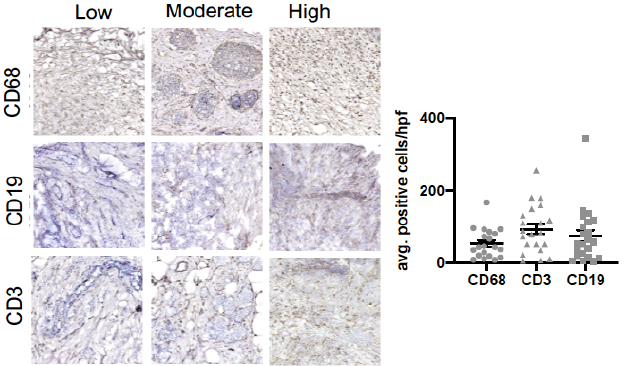
Figure 1. B cell, T cell and macrophage infiltration in breast tumor samples . Immunohistochemical analysis of breast tumor samples showing expression of CD68+ (macrophages), CD19+ (B cells) and CD3+ (T cells) cells. Table 2. Correlations among immune infiltration markers and known behavioral and biological mediators/moderators.